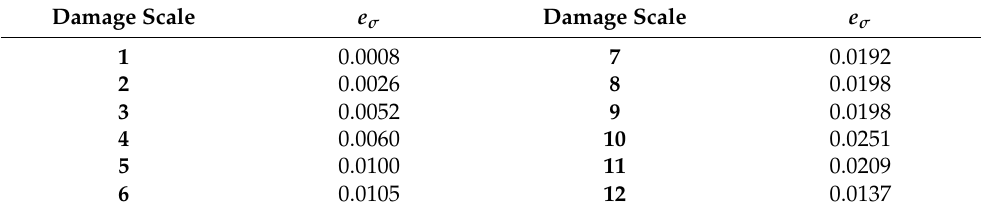
Table 3. Errors quantification and comparison of multi-defect reconstructions in simulation.